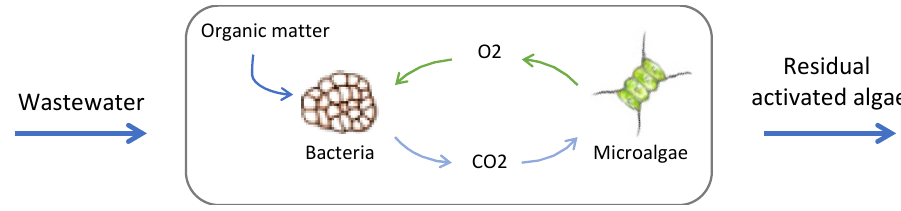
Figure 3. Aerobic treatment step.